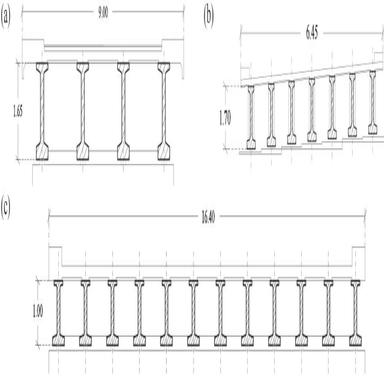
Example of typical cross-sections of bridge decks: (a) 4 beams, (b) 7 beams and (c) 12 beams.